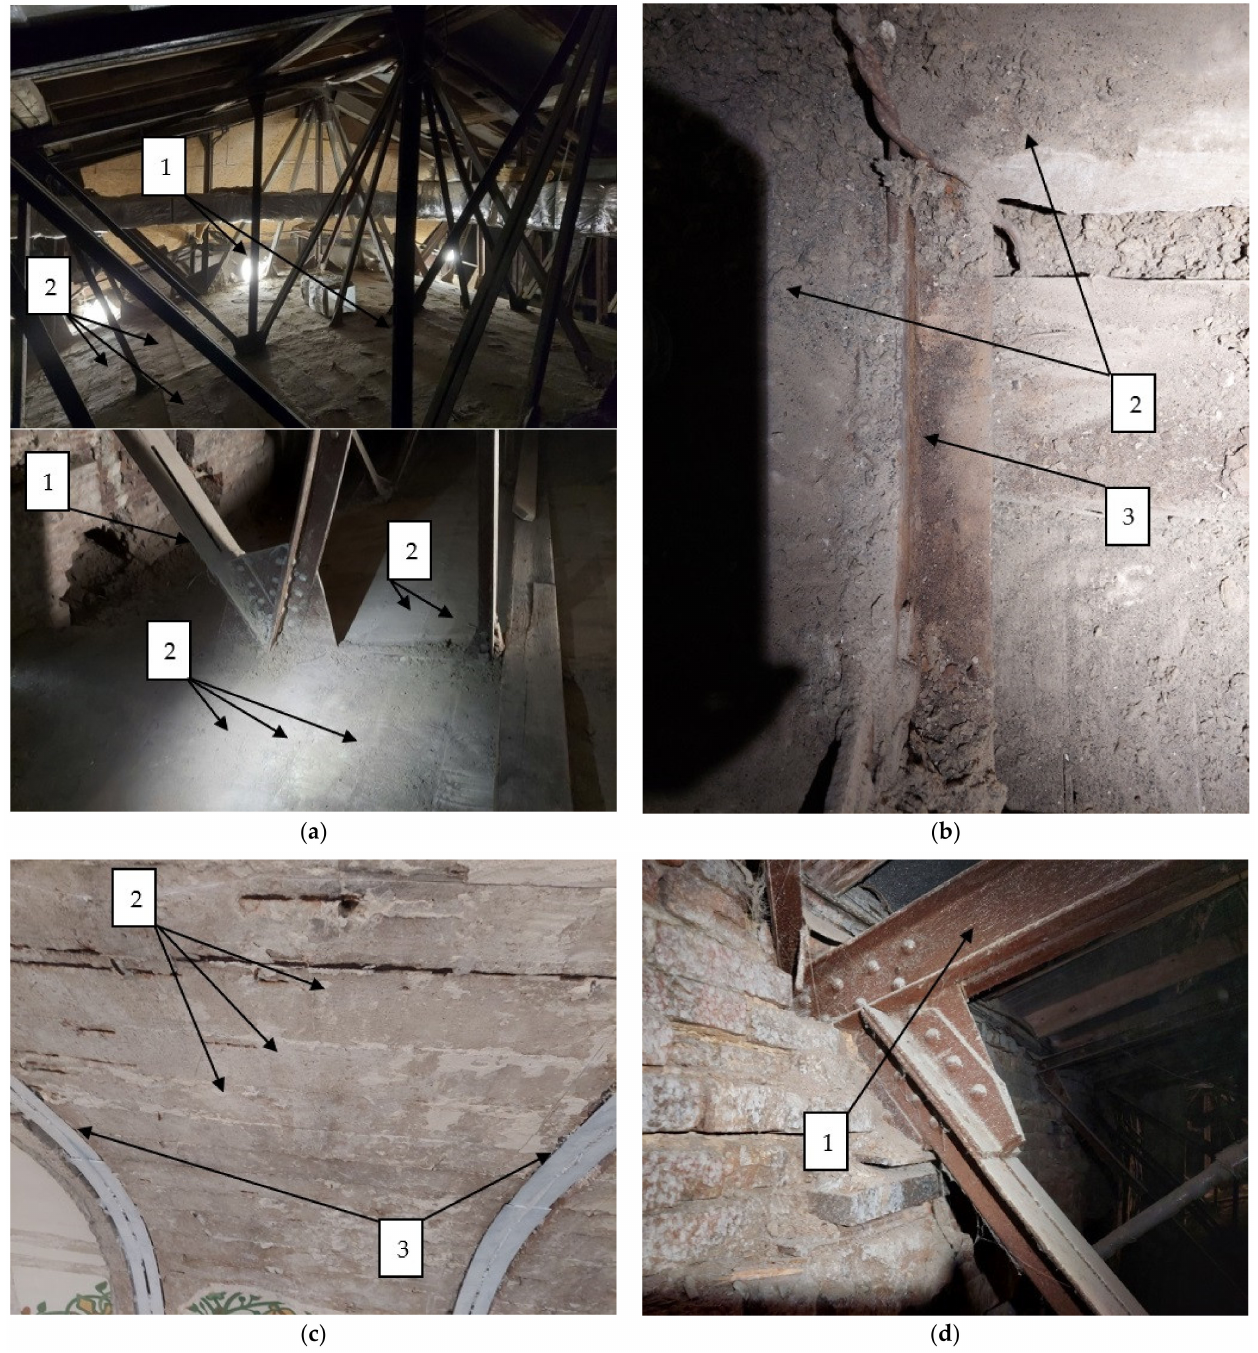
Figure 4. Construction of the attic ceiling: ( a ) general view of the steel roof trusses (1) and precast reinforced concrete elements (2) after cleaning the thermal insulation; ( b ) the bottom chord of the truss (3) which supports the precast reinforced concrete elements (2); ( c ) general view of the cover construction from below—precast reinforced concrete elements (2) are supported on the bottom chord of the steel truss (3) and form the vault of the hall; ( d ) the top chord of steel trusses is supported on the brick walls (source: